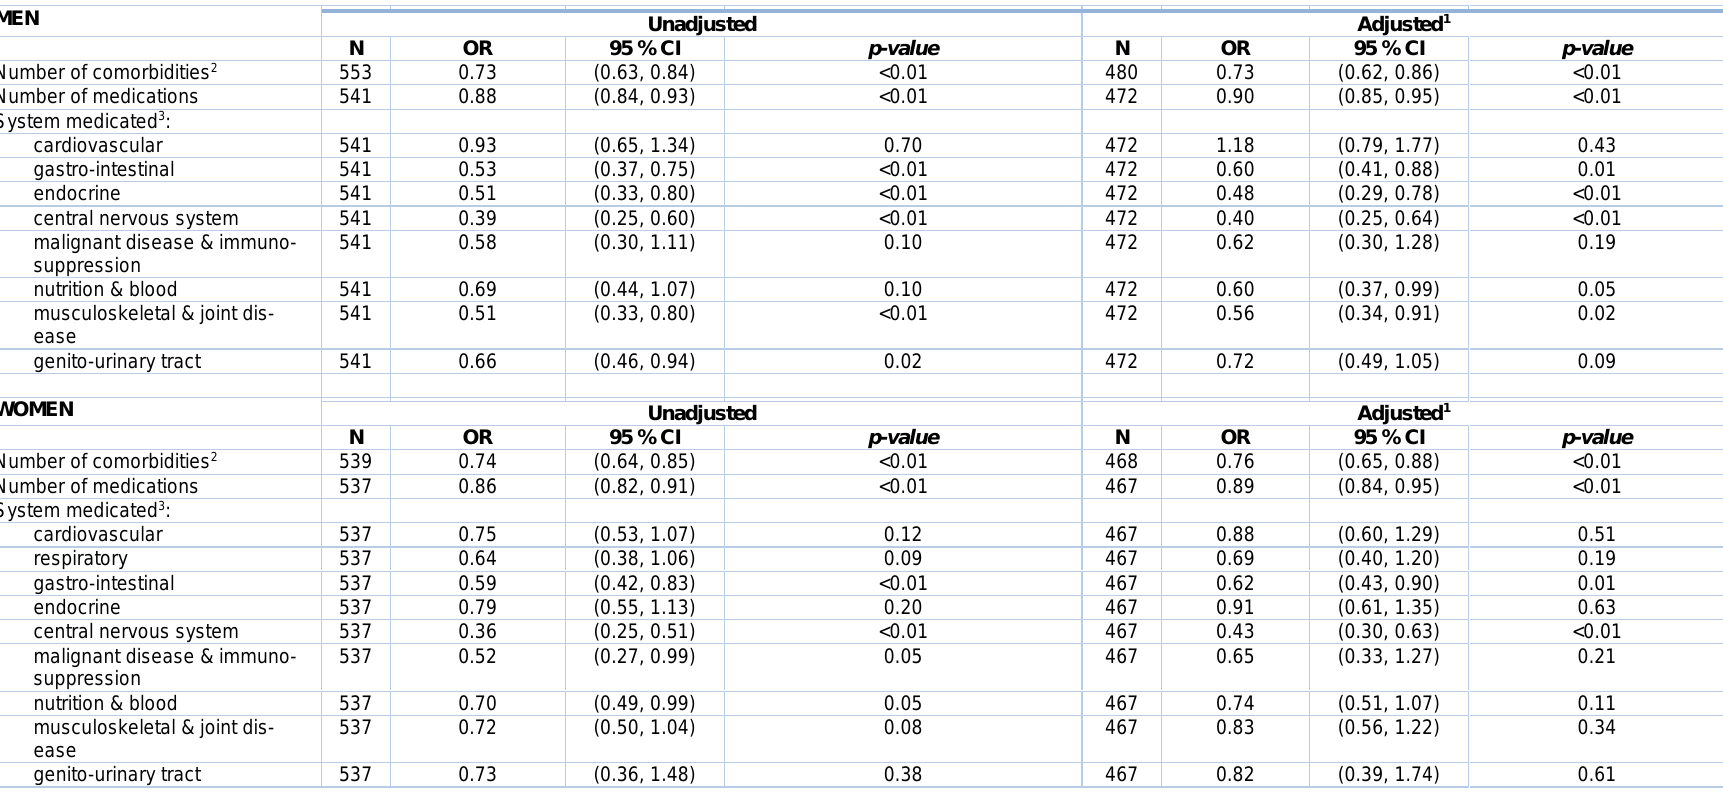
Table 2: Number of comorbidities, number of medications and system medicated as explanatory variables for activity score (low, medium, high) - Odds ratios are the odds of being in a higher activity score category compared to being in a lower